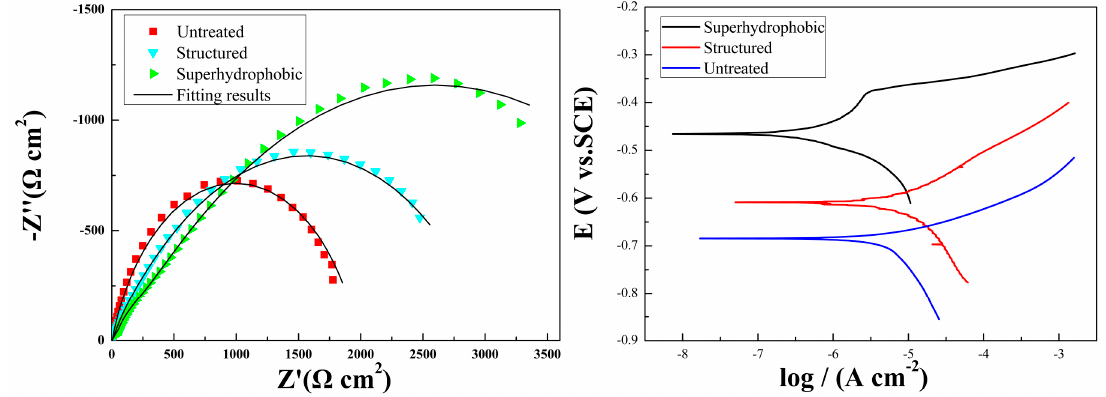
Figure 7. Nyquist plots ( a ) and Potentiodynamic polarization curves ( b ) of untreated Q235 carbon steel samples, structured Q235 carbon steel samples, and superhydrophobic Q235 carbon steel samples.